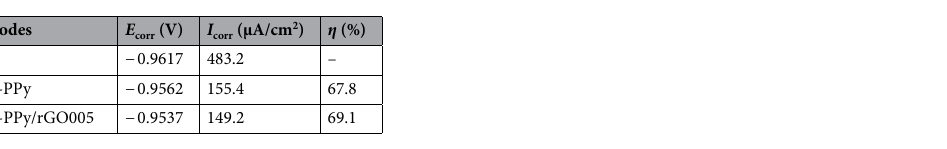
Table 1. The corrosion inhibition efficiencies ( η ) of anodes.